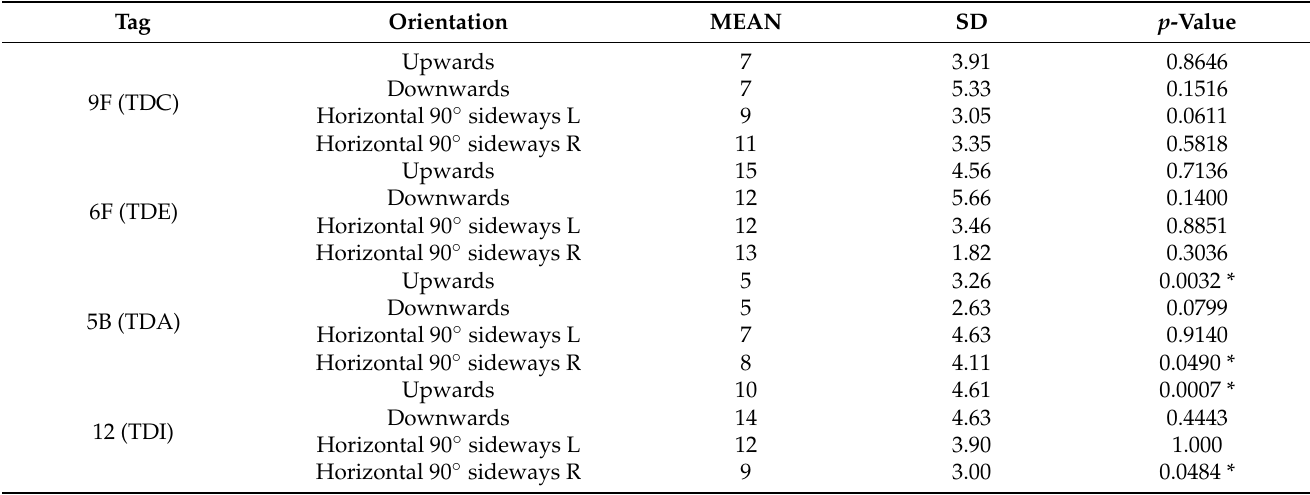
Figure 12. The total number of scans per tag for each type and distance per 3 min in a laboratory. Table 6. Experimental results of the Orientation.